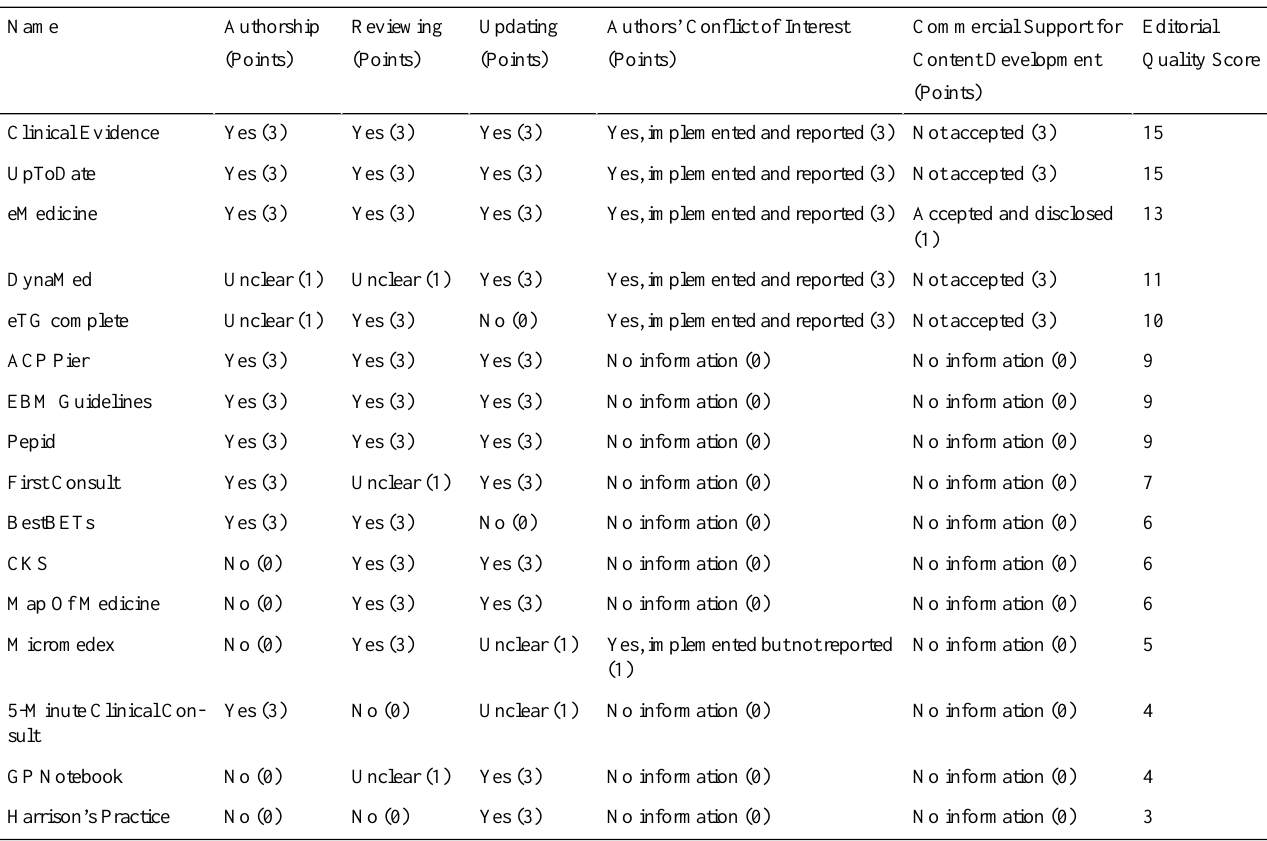
Table 4. Editorial quality of EBP point-of-care summary providers